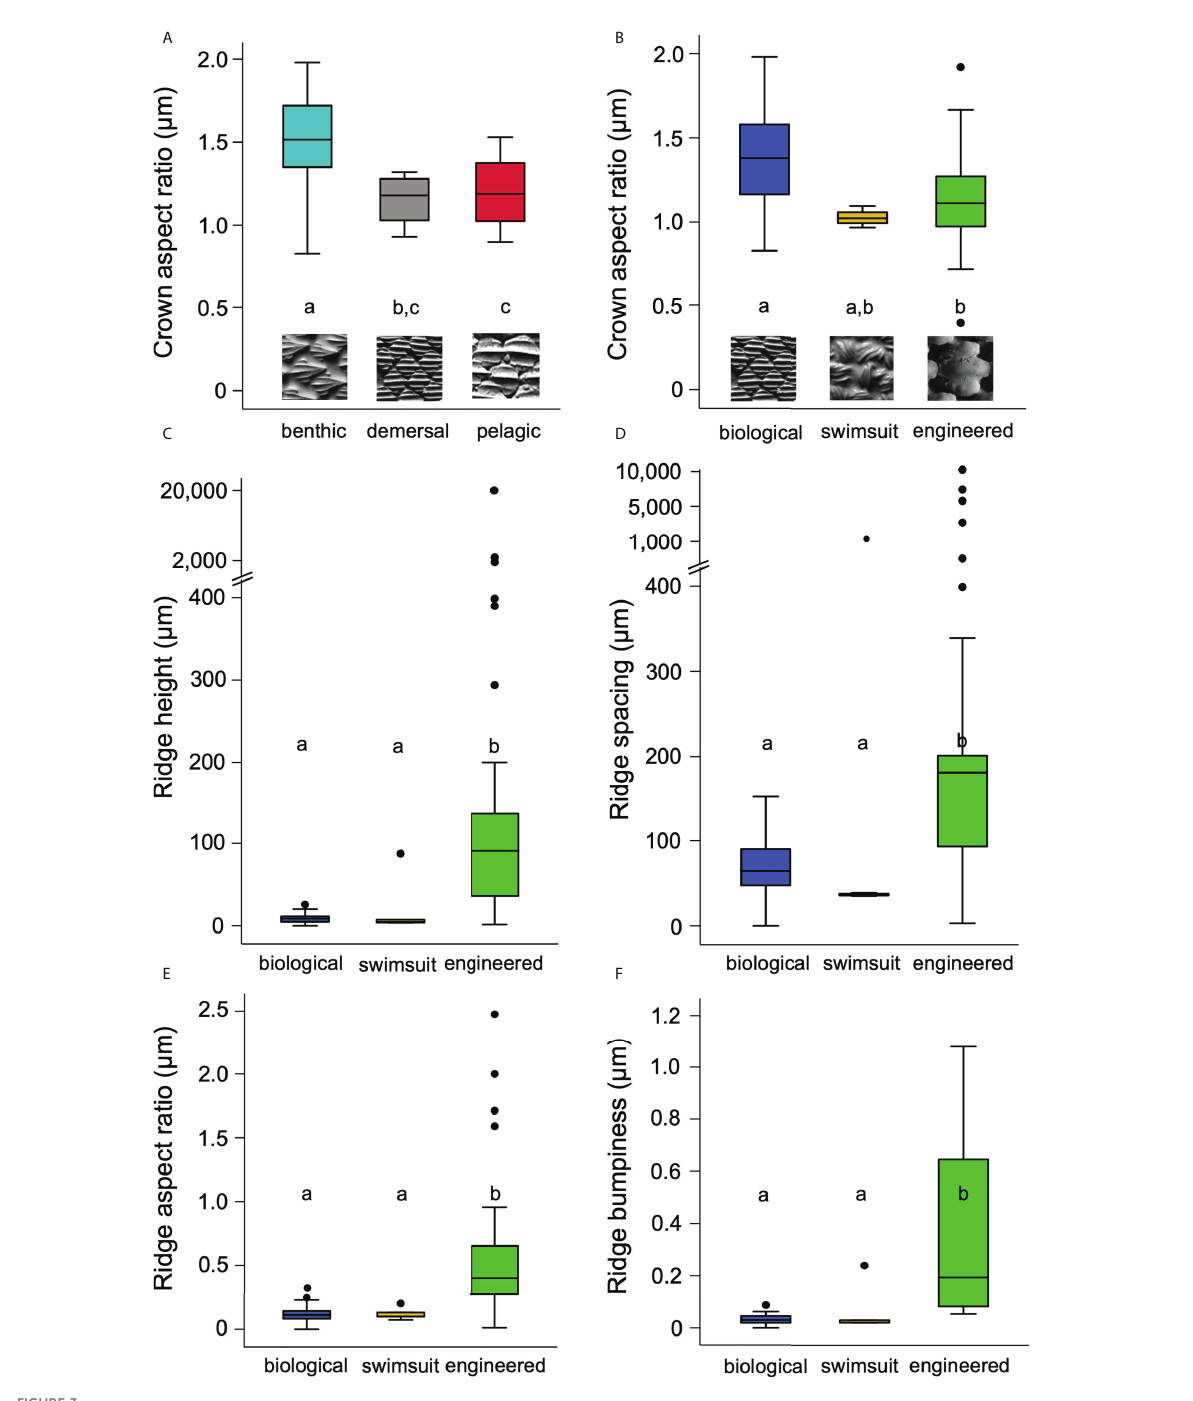
FIGURE 3 Surface characteristics for materials studied. Signi fi cant groupings are marked by letters. (A) Denticle crown aspect ratio versus the three different habitat groups of sharks. Insets represent one shark species from each habitat group: benthic (chain catshark), demersal (Atlantic sharpnose shark), and pelagic (white shark). (B) Crown aspect ratio versus the three types of materials: biological (Atlantic sharpnose shark), swimsuit (Speedo Lzr ® Racer Elite 2), and engineered (shark-inspired surface, Domel et al., 2018b). (C) Ridge height versus material type. (D) Ridge spacing versus types of materials. (E) Ridge aspect ratio versus material type. (F) Ridge bumpiness versus material type. Note that y-axes in (C, D) are broken to display the large denticle ridge height and spacing